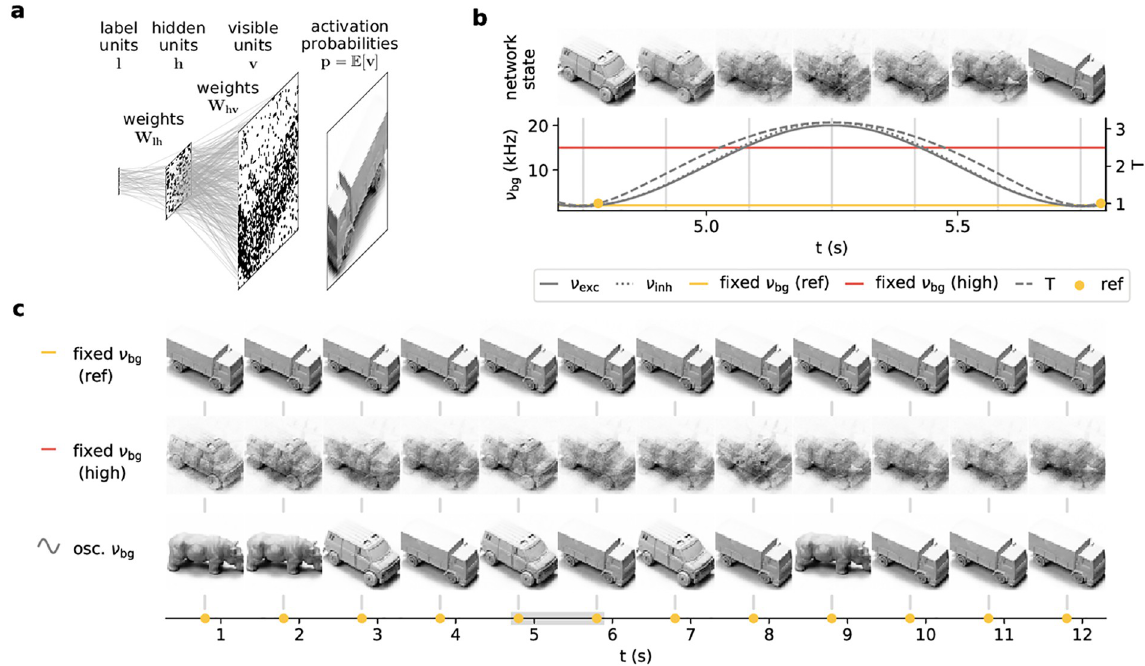
Fig 3. Background oscillations improve generative properties of spiking sampling networks. (a) Architecture of a hierarchical 3-layer (visible v , hidden h and label l ) network of LIF neurons and example layerwise activity. For a better representation of the visible layer statistics, we consider neuronal activation probabilities p ( v | h ) rather than samples thereof, to speed up the calculation of averages over (conditional) visible layer states. Here, we show a network trained on images from the NORB dataset. (b) Evolution of the activation probabilities of the visible layer (top) over one period of the background oscillation (bottom). (c) Evolution of the visible layer over multiple periods of the oscillation compared to a network with constant background input at the reference rate (2 kHz, top) and at a high rate (10 kHz, middle), cf. also yellow and red lines in (b). The activation probabilities are shown whenever the reference rate (see panel b) is reached. The gray bar denotes the period shown in (b).